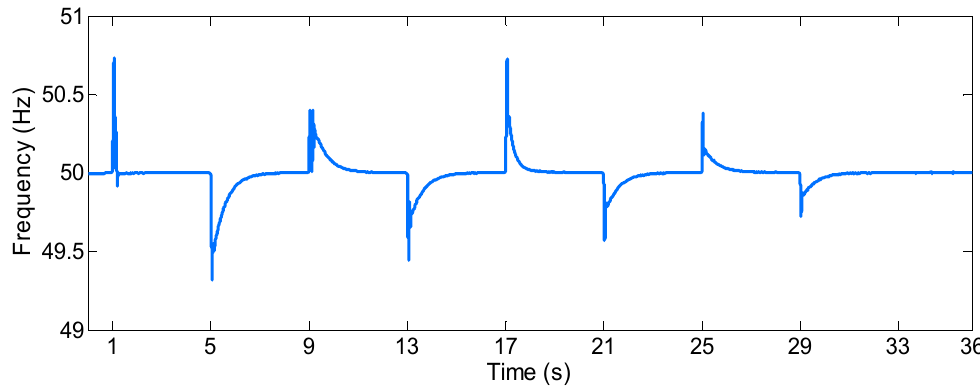
Figure 14. Frequency of the MG during the restoration process.